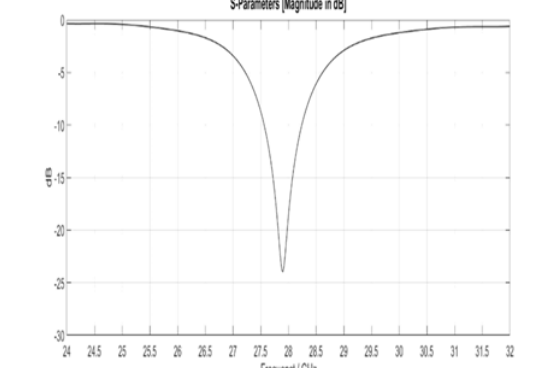
Fig 4. Return loss response of the antenna with  R= 0.2 mm.